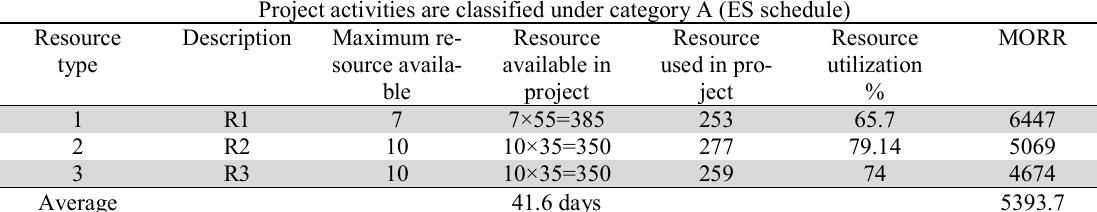
The value of the objective function obtained under ES priority rule for case 1 Project activities are classified under category A (ES schedule) Resource